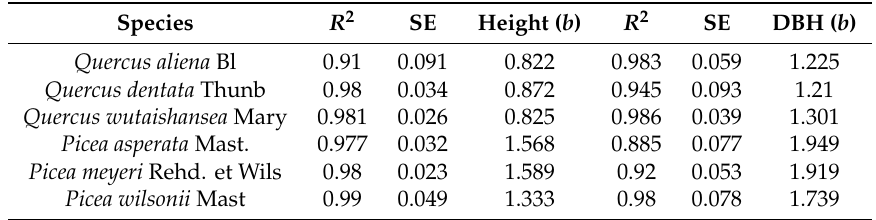
Table 3. Growth di ff erence equation of similar tree species in the same province. Species R 2 SE Height ( b ) R 2 SE DBH ( b ) Quercus aliena Bl 0.91